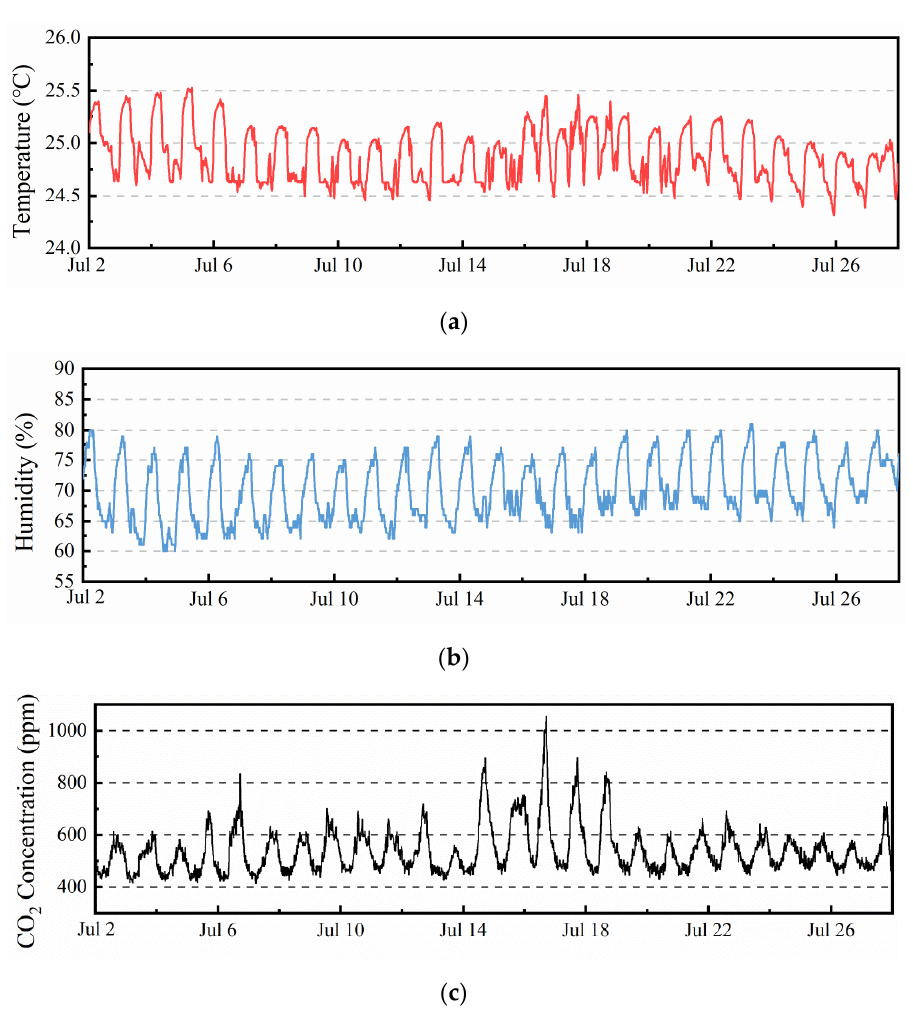
Figure 2. Temperature, Humidity and CO 2 concentration profile in July (No. 113): ( a ) Temperature profile; ( b ) Humidity profile; ( c ) CO 2 concentration profile .